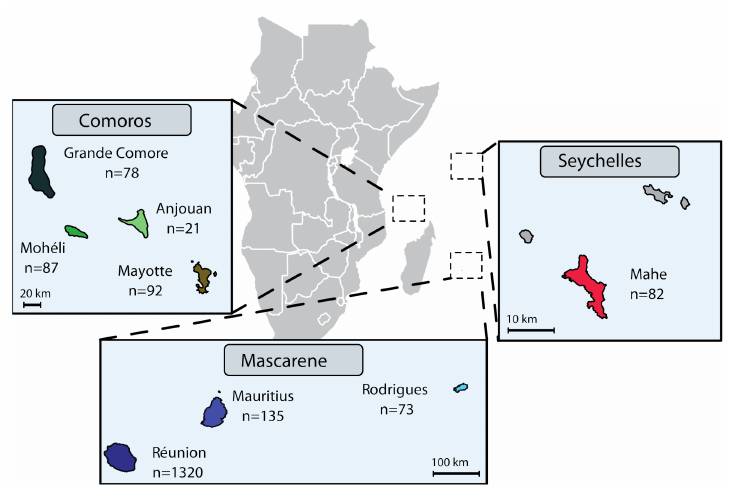
Figure 1. Geographical location and sample numbers of the Xanthomonas citri pv. citri strain collection analysed in the present